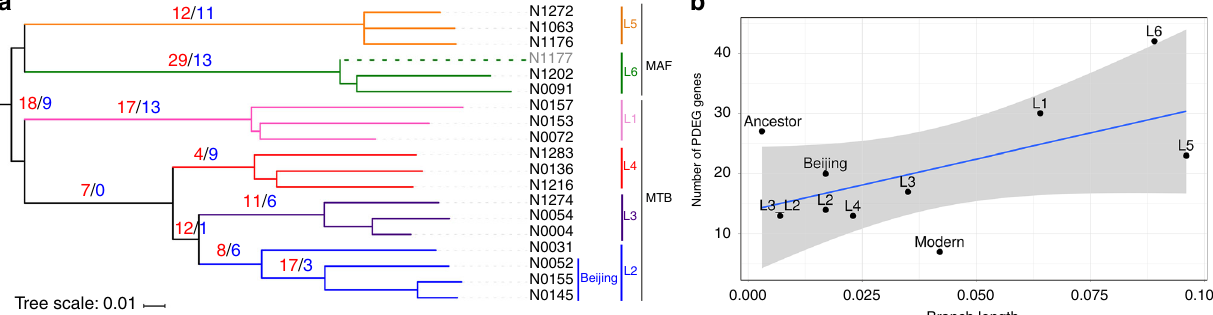
Fig. 2 Gene expression changes across the MTBC phylogeny. a Number of genes differentially expressed (red up, blue down) in each of the main branches of the MTBC phylogeny. The phylogeny was constructed using Illumina sequencing data, the Maximum-Likelihood algorithm and a bootstrapping of 1000 replicates. Sample N1177 is included to shown the complete phylogenetic picture, but it was not included for further analyses. b Number of PDEG genes in each of the main MTBC branches plotted against the genetic distances